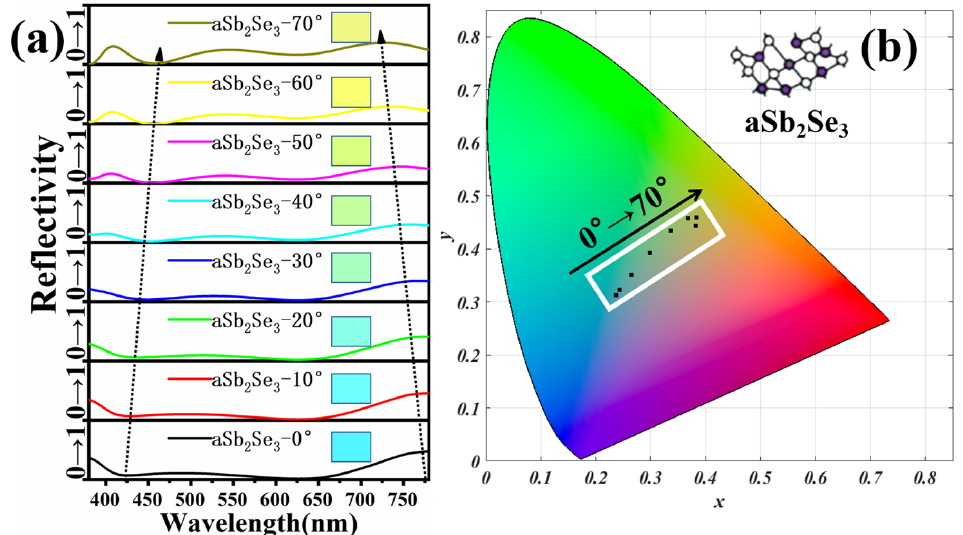
Figure 6. ( a ) Reflectivity spectra and corresponding colors of different incidence angles under aSb 2 Se 3 state; ( b ) color coordinates corresponding to different incidence angles on the chromaticity diagram under aSb 2 Se 3 state.